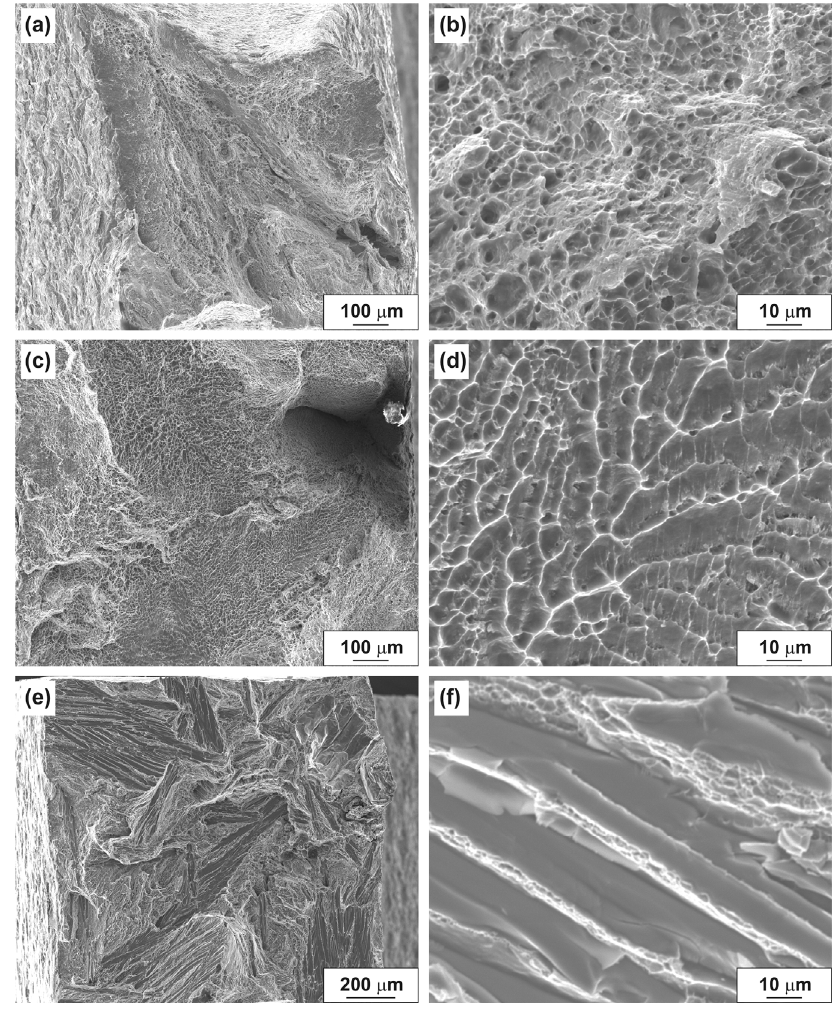
Figure 10. Fracture surfaces of aluminum alloys in as-cast state after tensile testing: ( a , b ) Al–10% La; ( c , d ) Al–9% Ce; ( e , f ) Al–7% Ni.